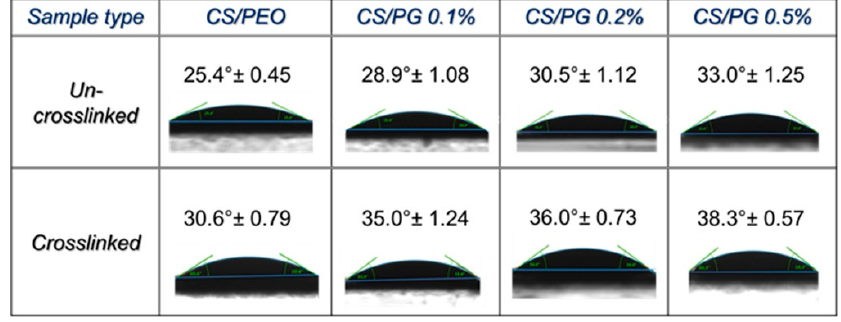
Figure 7. Water contact angle of all engineered nanofibrous scaffolds.